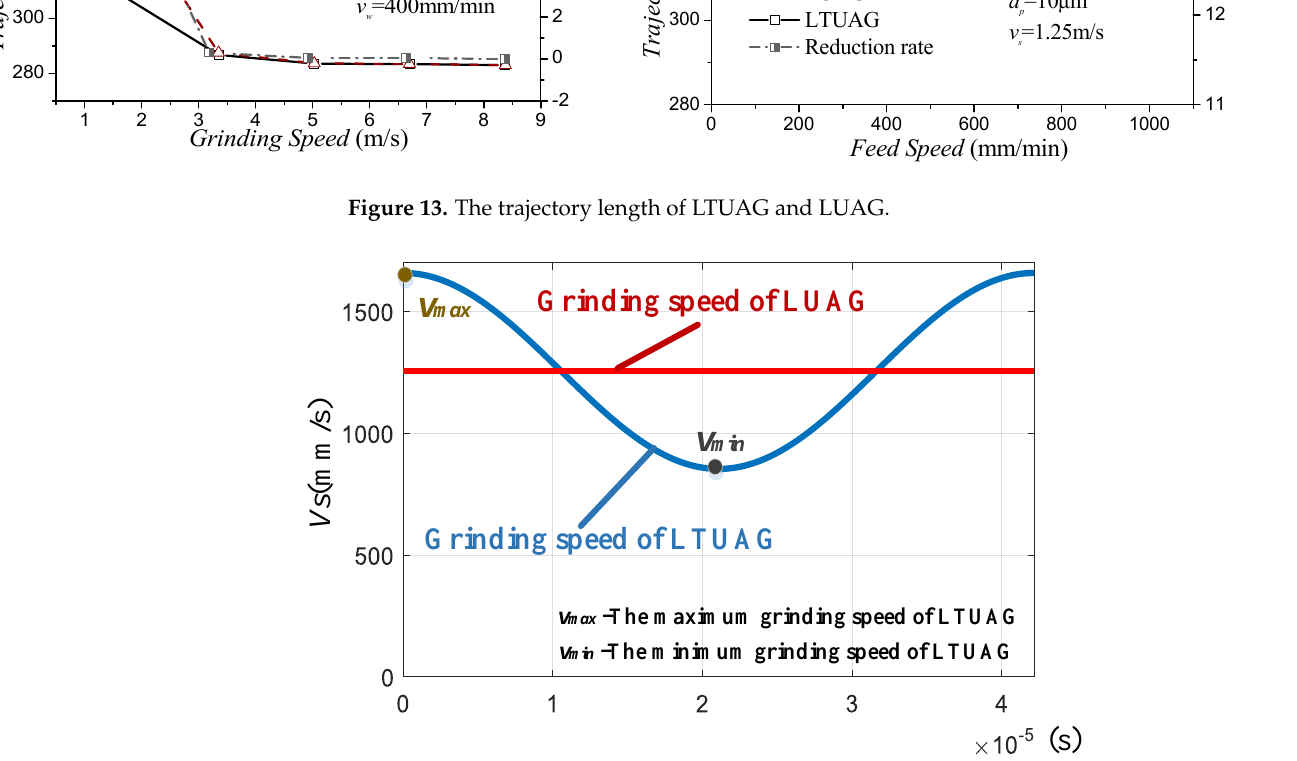
The surface roughness of LUAG and LTUAG is measured with the MarSurf PS1 rough-